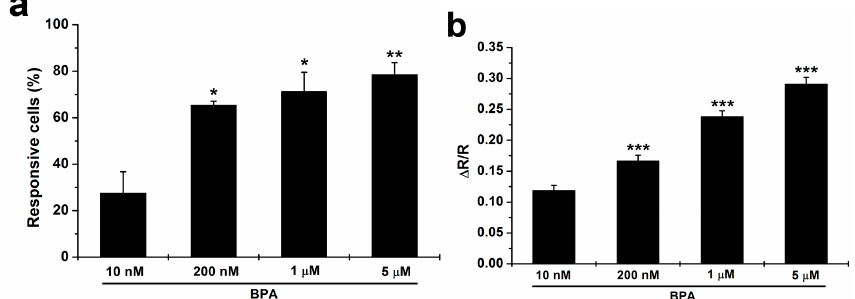
Figure 3. Both number of responding cells and amplitude of response were dependent on BPA concentration. ( a ) Percentage of responsive cells. Total cell number for each condition was n = 434 at 10 nM, n = 350 at 200 nM, n = 713 at 1 µ M, n = 902 at 5 µ M. Welch’s F -test and Games–Howell post hoc test; * p < 0.05, ** p < 0.01 for each BPA dose vs. the lowest one (10 nM). ( b ) Response peak amplitudes. Total number of responsive cells for each condition was n = 116 at 10 nM, n = 229 at 200 nM, n = 543 at 1 µ M, n = 729 at 5 µ M. Kruskal–Wallis H -test and Dunn’s post hoc test; *** p < 0.001 for all the possible